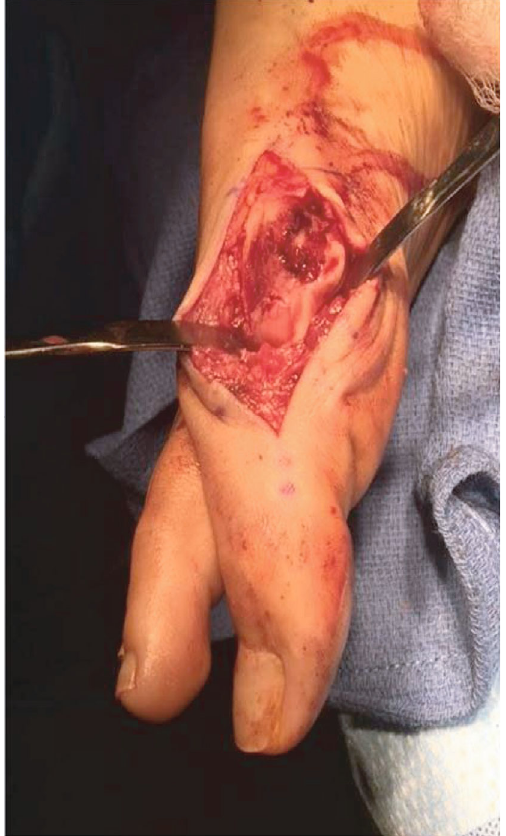
Figure 4: Dorsomedial incision of the fi rst MTP joint shows Outerbridge classi fi cation grade IV chondromalacia with 50% of metatarsal head cartilage missing.